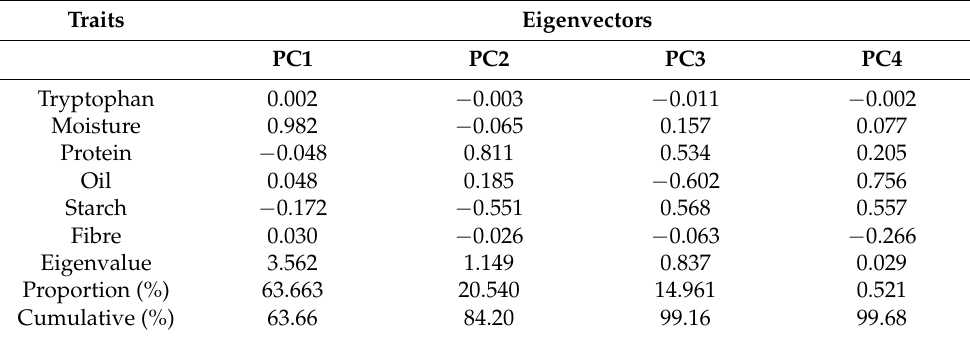
Table 3. Principal component analysis of maize hybrids for quality traits. Traits